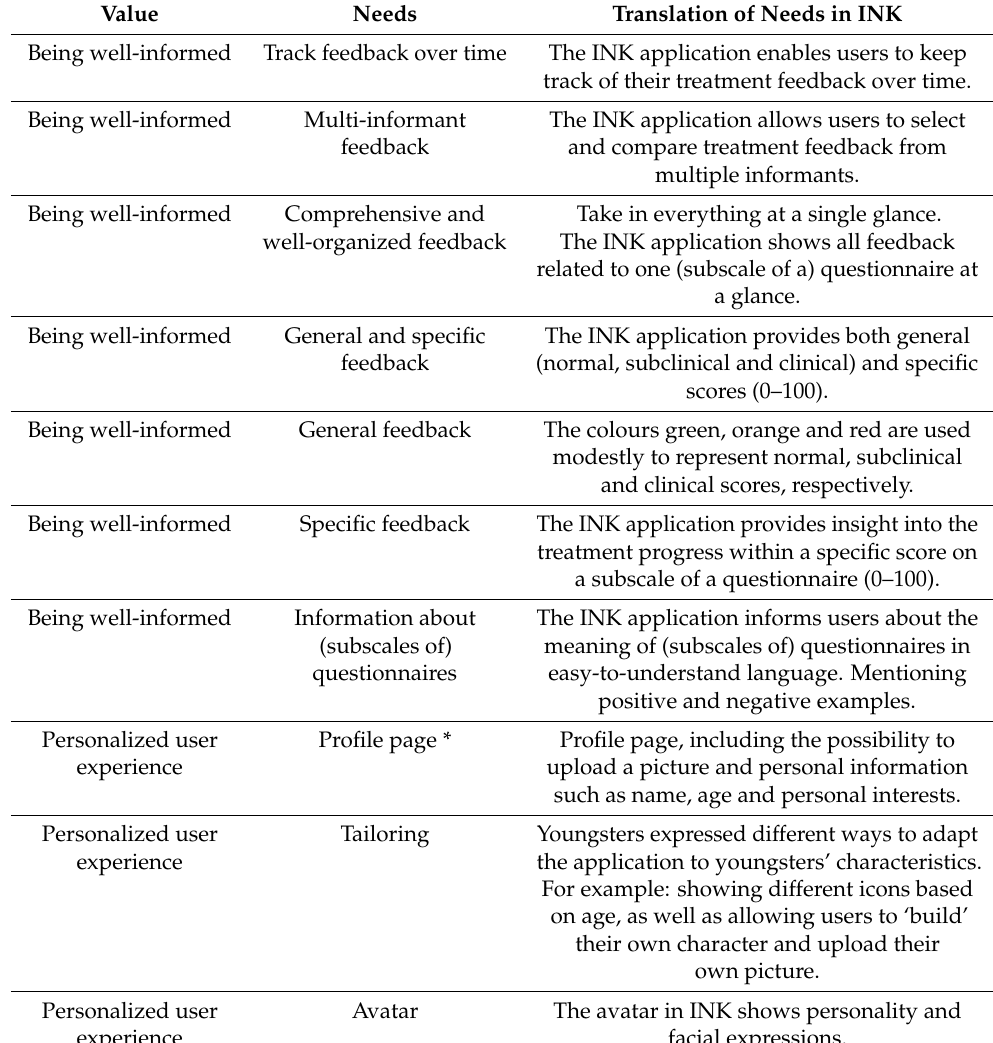
Table 2. Overview of preferences of the youngsters for the design of INK-Value Specification. Value